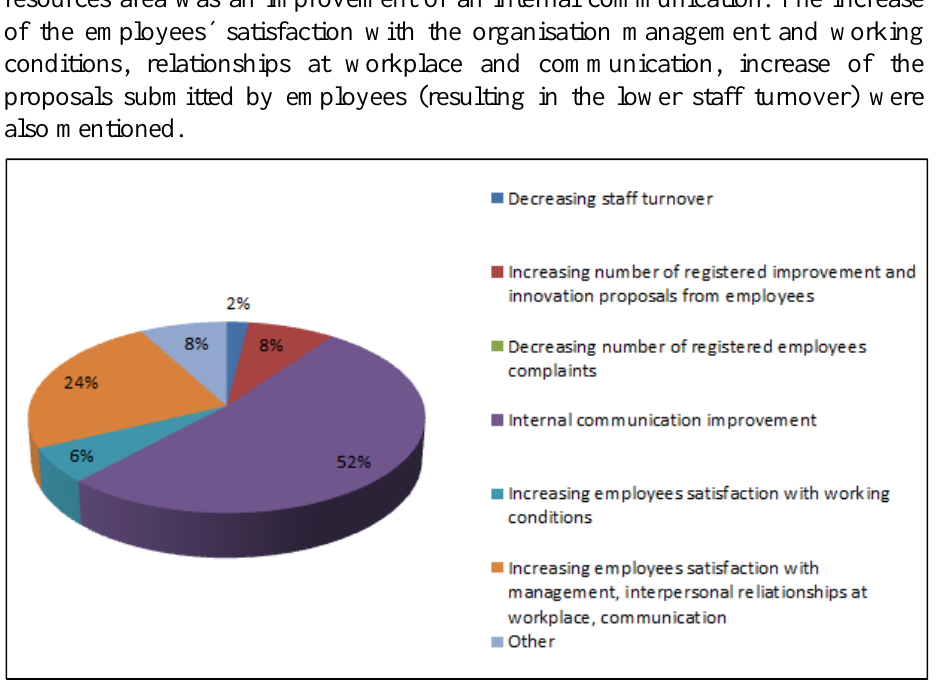
Fig. 5 Results of question 5 a) Impact of participation in NQASR on human